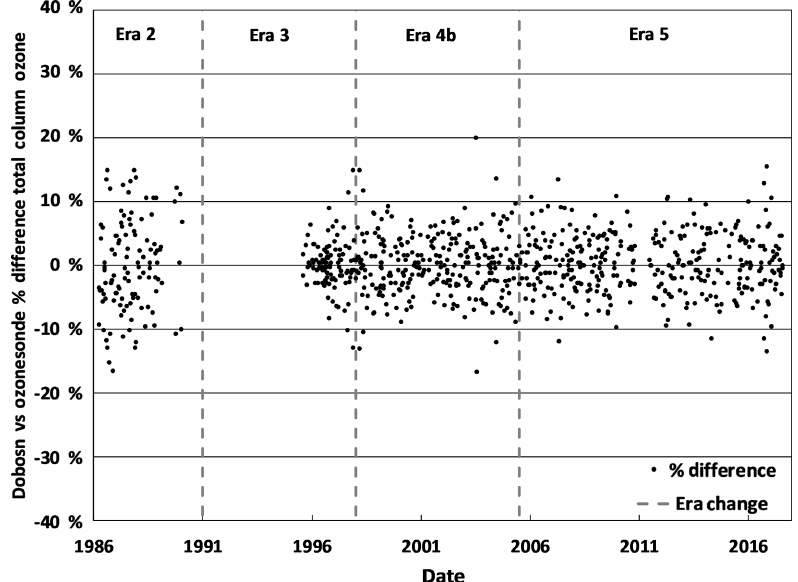
Figure 12. American Samoa Dobson vs. Ozonesonde total column ozone